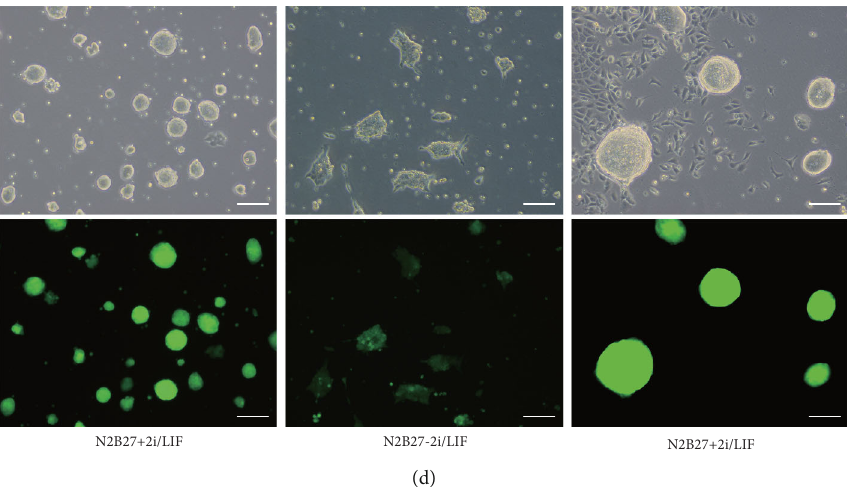
Figure 1: The screening procedure: (a) outline of the research procedure and (b) technical route. 2 : 4 × 10 7 lentiCas9-Blast-expressing mESCs were transfected with GeCKO (v2) lentiGuide-Puro in 2i/LIF, and then input 1 was collected after 48 hours puromycin selection and input 2 after additional 3 passages (9 days) cultured in N2B27+2i/LIF; experimental group was collected after 2 passages of mutation period and 2 passages of 2i/LIF withdrawal and one more passage in 2i/LIF conditions. 2.4E7 stands for 2 : 4 × 10 7 mES cells. (c) OG2 mESCs were transfected with Cas9-Blast plasmid and GeCKO v2.0 DNA plasmids in N2B27+2i/LIF medium. Di ff erentiation was enabled by inhibitor removal and enrichment performed by restoring 2i/LIF. (d) Phase and fl uorescence images of mES cells at the three stages. Scale bar, 100 μ